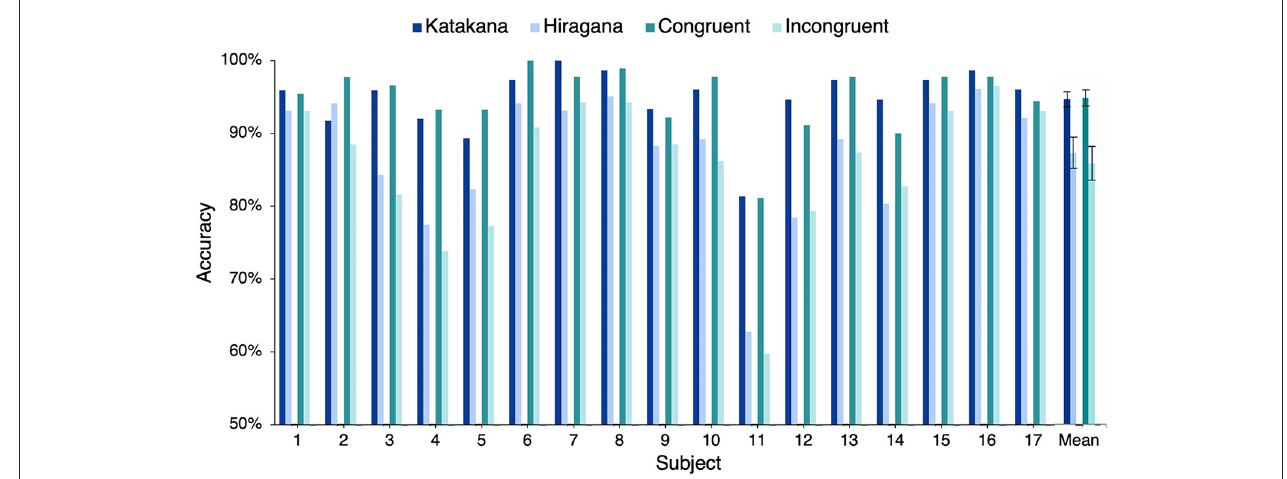
FIGURE 2 | Behavioral task performance: this plot shows the percentage of Japanese words correctly associated with the image description by the